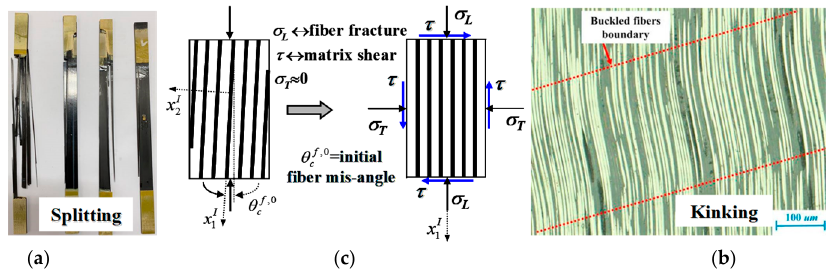
Figure 2. ( a ) Longitudinal tension-induced fiber splitting failure, ( b ) longitudinal compression-induced fiber kinking failure [12], ( c ) load decomposition in fiber misligned coordinate system.